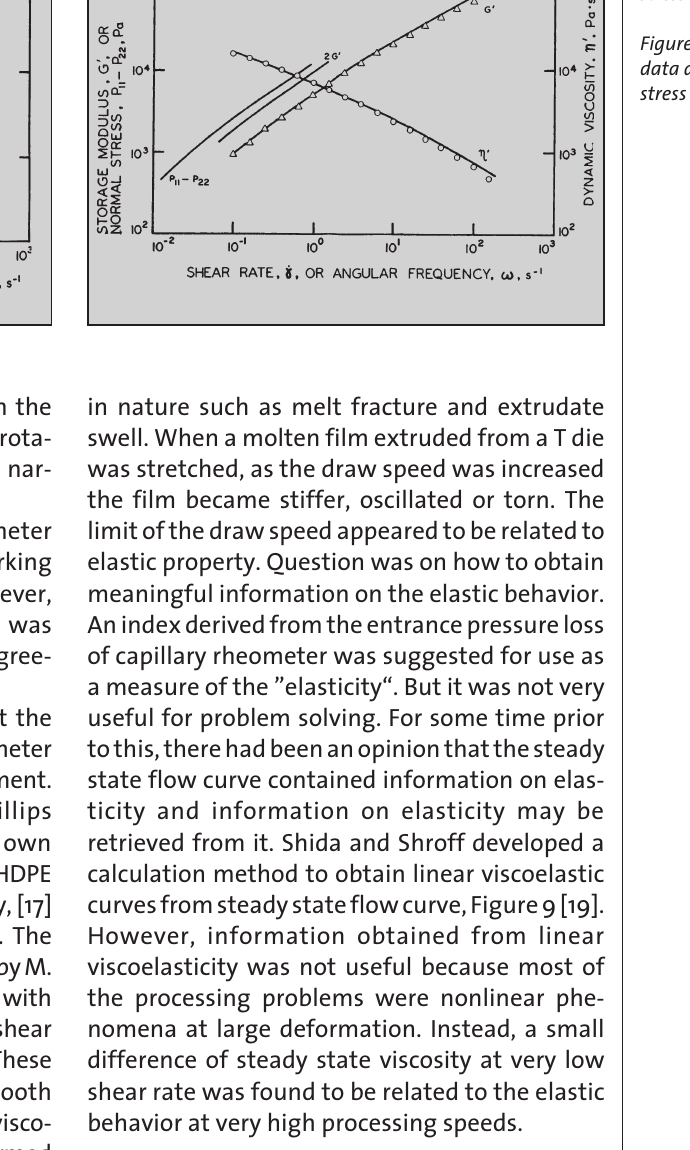
Figure 8 (left): Viscoelastic data and normal stress data. Figure 9 (right): Viscoelastic data and normal stress